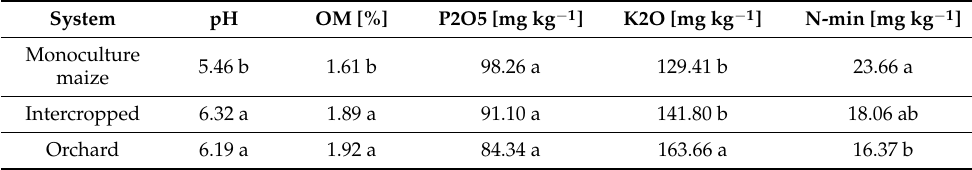
Table 2. Soil chemical properties during maize vegetation.